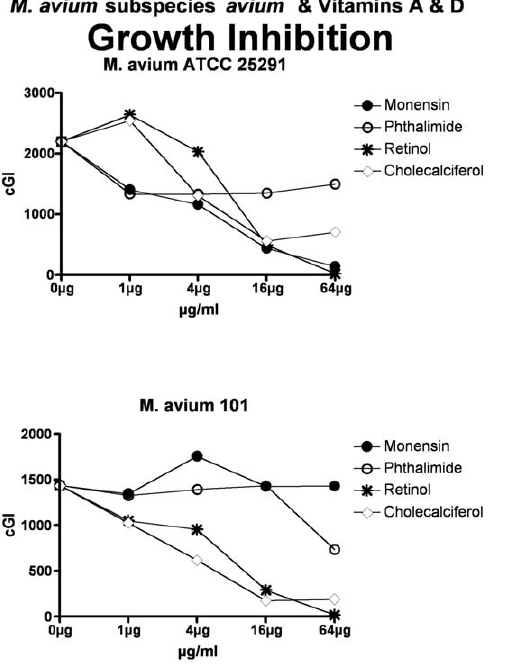
Figure 2. Both vitamins A & D inhibit M.avium . The inhibitory control is Monensin, and the non-inhibitory control is Phthalimide. Note that as previously [20,21,30], Monensin does not inhibit M avium 101. cGI=cumulative Growth Index.